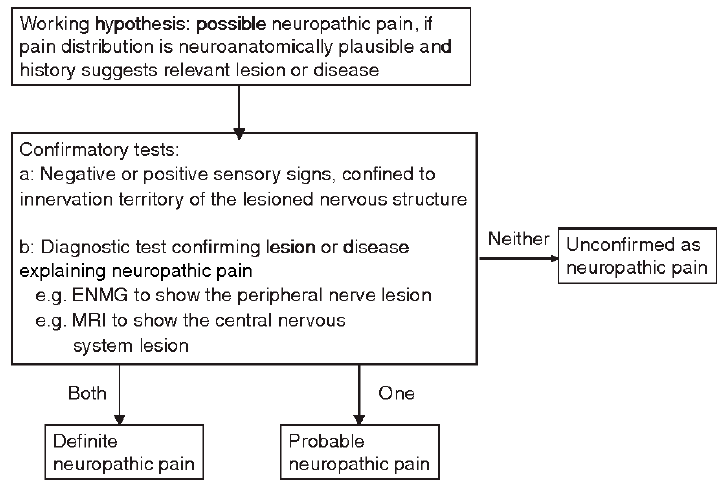
Figure 1. NeuPSIG grading system [50].